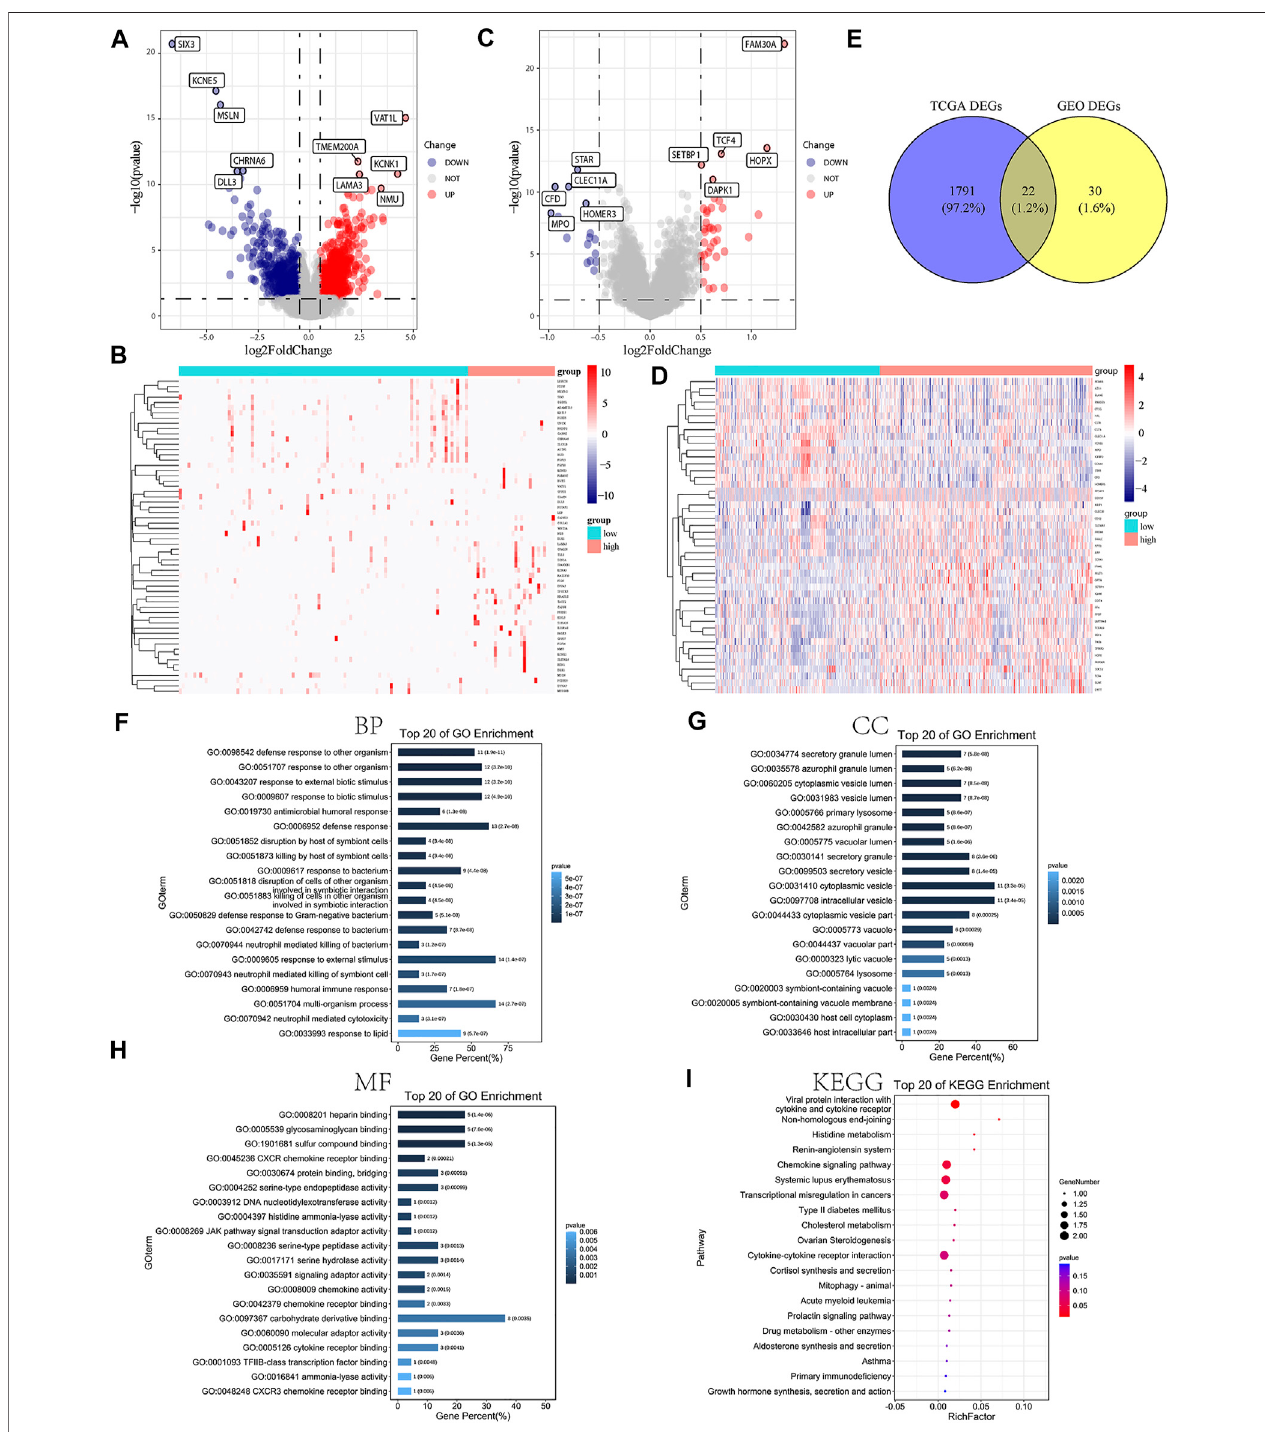
FIGURE 3 | DEG analysis and functional enrichment analysis based on the related risk score model of m6A-related lncRNAs. (A,B) Volcano map and heatmap presenting the differential expression of DEGs between high- and low-risk AML patients in TCGA-AML dataset. (C,D) Volcano map and heatmap demonstrating the expression levelofDEGsbetweenhigh-andlow-riskAMLpatientsintheGEOdataset. (E) Venndiagramexhibiting22overlappedDEGsbetweenTCGA-AMLandGEO datasets. (F) GOBPtermssuggestingthetop20enrichedbiologicalprocesses. (G) GOCCtermsdemonstratingthetop20enrichedcellularcomponents. (H) GO MF terms indicating the top 20 enriched molecular functions. (I) KEGG enrichment analysis showing the top 20 enriched pathways.